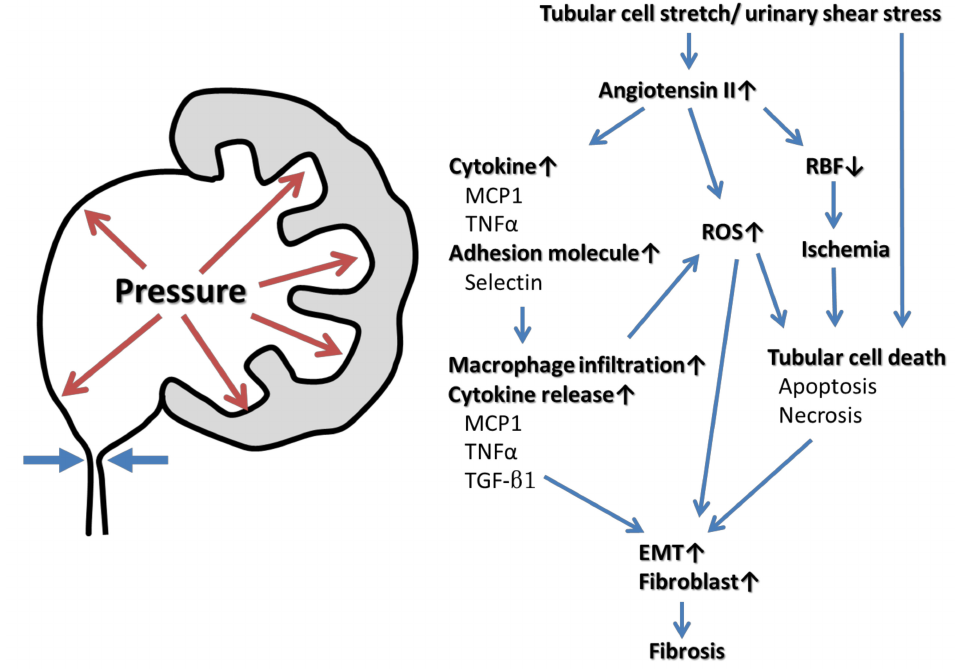
Figure 1. Mechanisms of UUTO causing kidney injury and